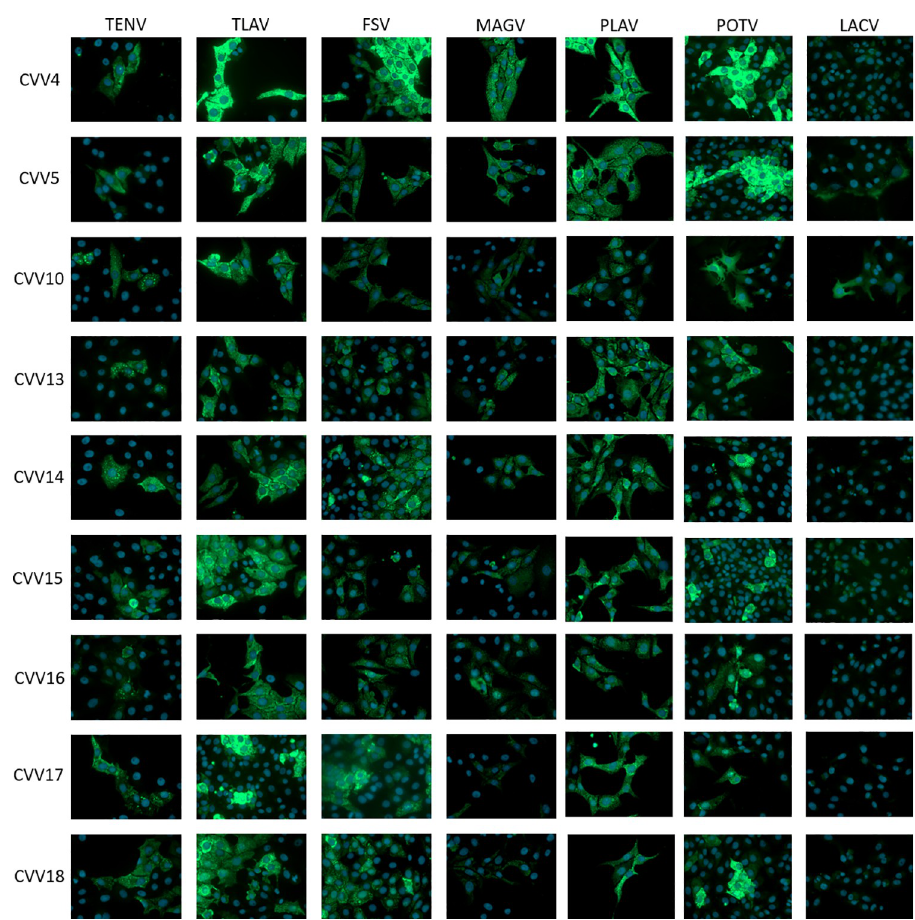
Fig 3. Cross-reactivity of anti-CVV MAbs with related orthobunyaviruses. Vero cells were grown on glass coverslips in 24-well plates, infected with viruses in the Bunyamwera serogroup at an MOI 1.0 and fixed 24 hours post- infection. Cells were stained with anti-CVV MAbs and a goat anti-mouse FITC labeled conjugate (green). Nuclei of cells were stained with DAPI (blue).